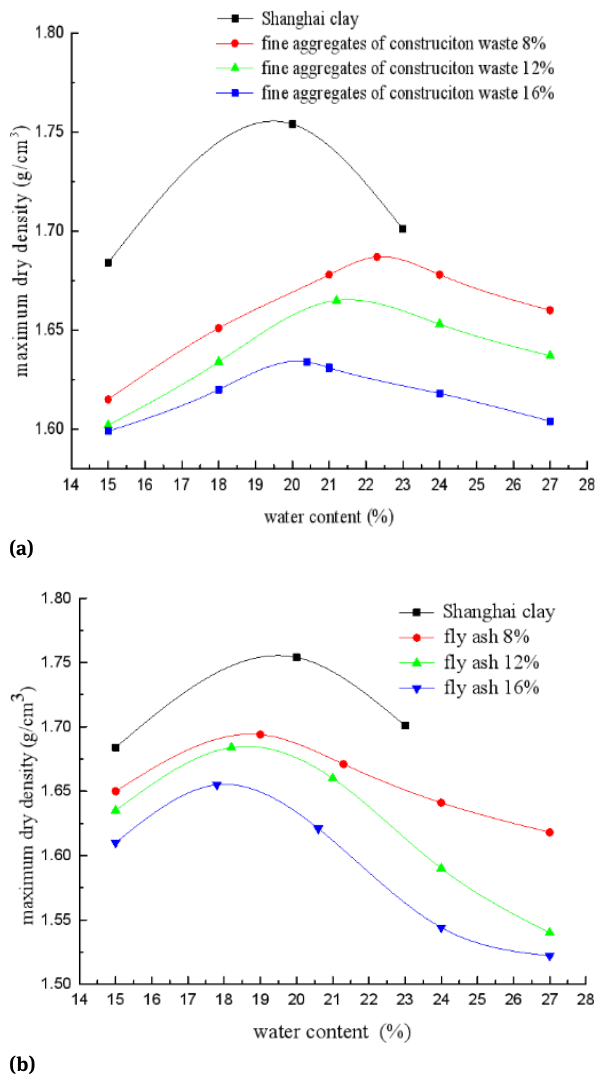
Figure 5: Compaction curve of clay with different content of fine aggregates of construction waste (a) and fly ash